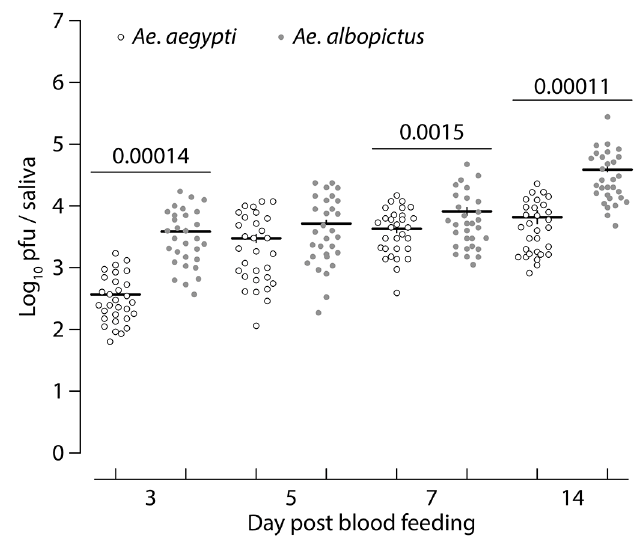
Figure 3. Kinetics of viral transmission after oral exposure of Ae. albopictus and Ae. aegypti to MAYV. The transmission rates were determined by titration of the saliva collected from mosquitoes at day 3, 5, 7, and 14 post-virus exposure. Each circle corresponds to the virus titer of an individual subject, and the solid horizontal line represents the mean virus titer of the group.